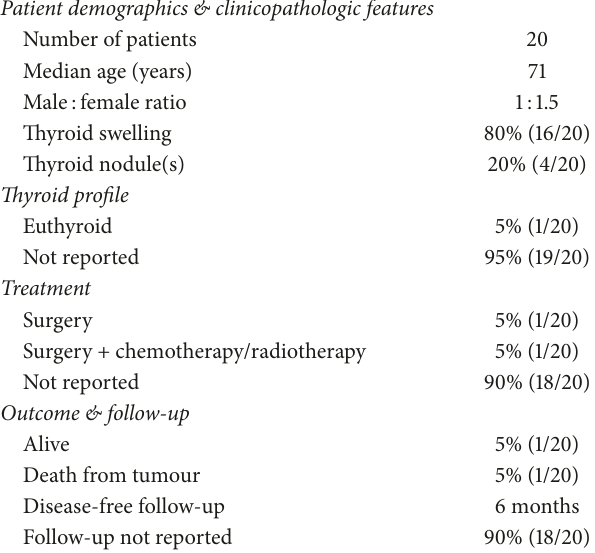
Table 1: The table shows demographics, clinicopathologic features, treatment, outcome, and follow-up of patients with anaplastic SCSC arising from TCV PTC. (Data based on the 20 reported cases including present